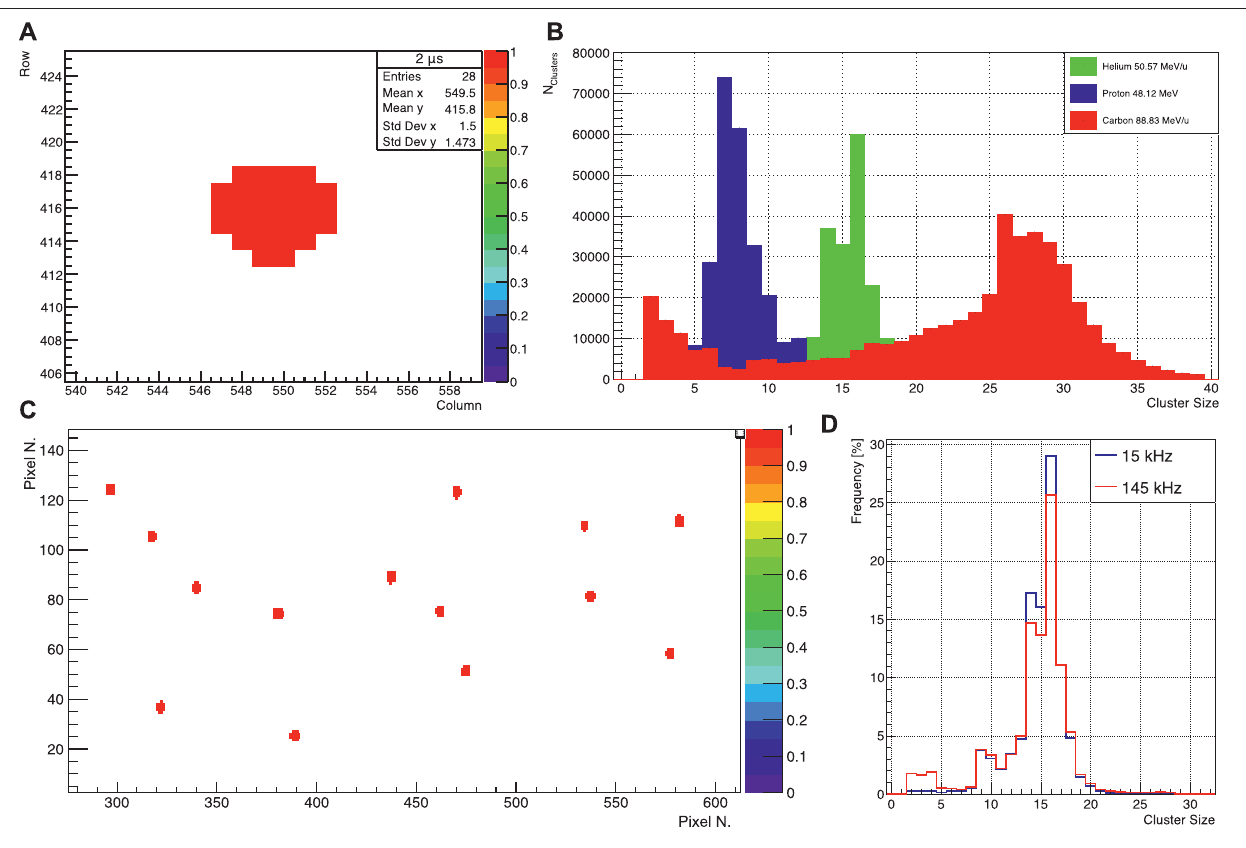
FIGURE 10 | (A) Example of a cluster detected by the ALICE pixel detector (ALPIDE) chip from an 241 Am source after 2 μ s. Frame period 1 MHz, Frame Duration 750 ns. (B) Proton, helium, and carbon ion cluster distributions at the minimum energies available at HIT. (C) ALPIDE Hit map in a high occupancy environment. (D) Cluster distribution in a single ALPIDE chip in both high (15 kHz) and low (145 kHz) occupancy environments. affected by scattering while crossing the object under study, a tracks using proton and helium primaries crossing two simulated higher number of tracks correctly reconstructed was obtained for cubic water phantoms with 5 and 16 cm size is shown. The study both phantoms [64]. The track reconstruction process currently was performed on charge diffused MC data. For helium ions, less